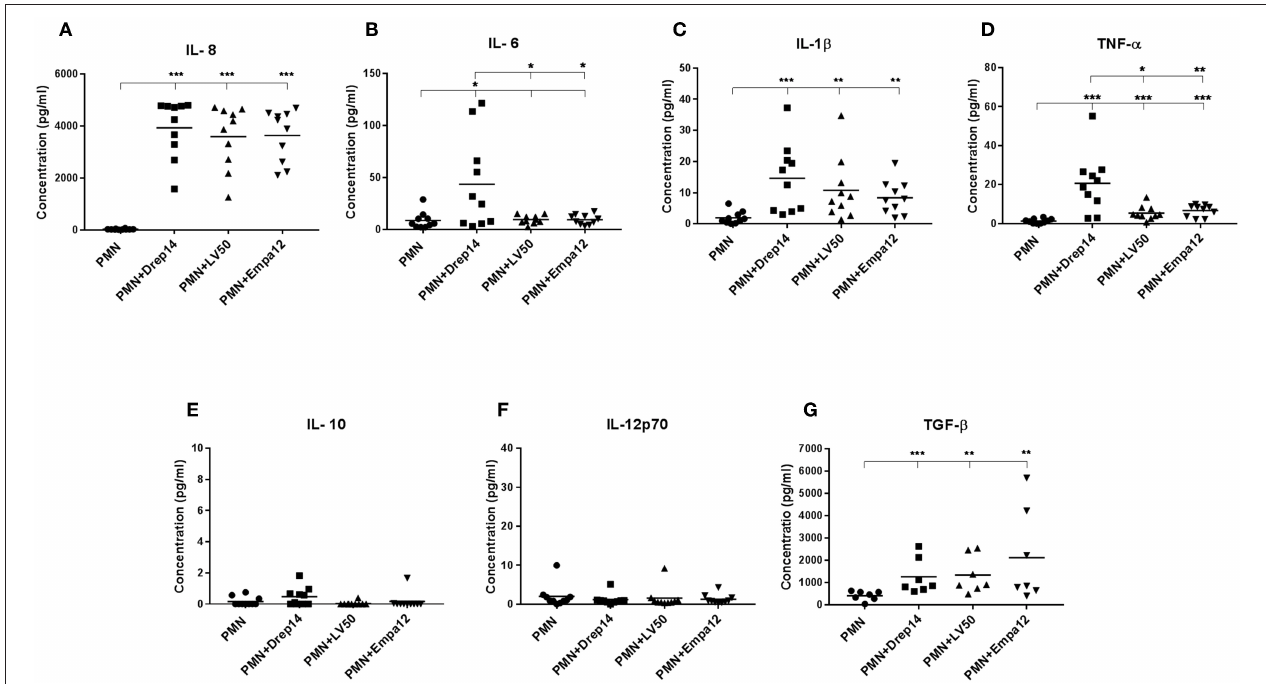
FIGURE 6 | Effect of Leishmania strains on cytokines production after ex vivo infection of human PMNs . Neutrophils were infected or not by Leishmania parasites (MOI of 10). Then, supernatants were collected after 18h of incubation. The amounts of (A) IL-8, (B) IL-6, (C) IL-1 β , (D) TNF- α , (E) IL-10, and (F) IL-12p70 protein were quantified from (50 µ L) culture supernatants using the BD Cytometric Bead Array (CBA) Human Inflammation Cytokines kit. The amount of (G) TGF- β was quantified from the supernatants (100 µ L) by Enzyme-linked immunosorbent assay (ELISA). Results were expressed as the cytokine concentration obtained from seven (TGF- β ) or ten sampled donors. The horizontal bars indicate the median value of cytokine production. Statistical pair- wise comparisons of PMN vs. each strain- infected PMN, and of strain- infected PMNs were performed using the Mann–Whitney test; * p < 0.05, ** p < 0.01, and *** p < 0.001 indicate statistically significant differences at the indicated p